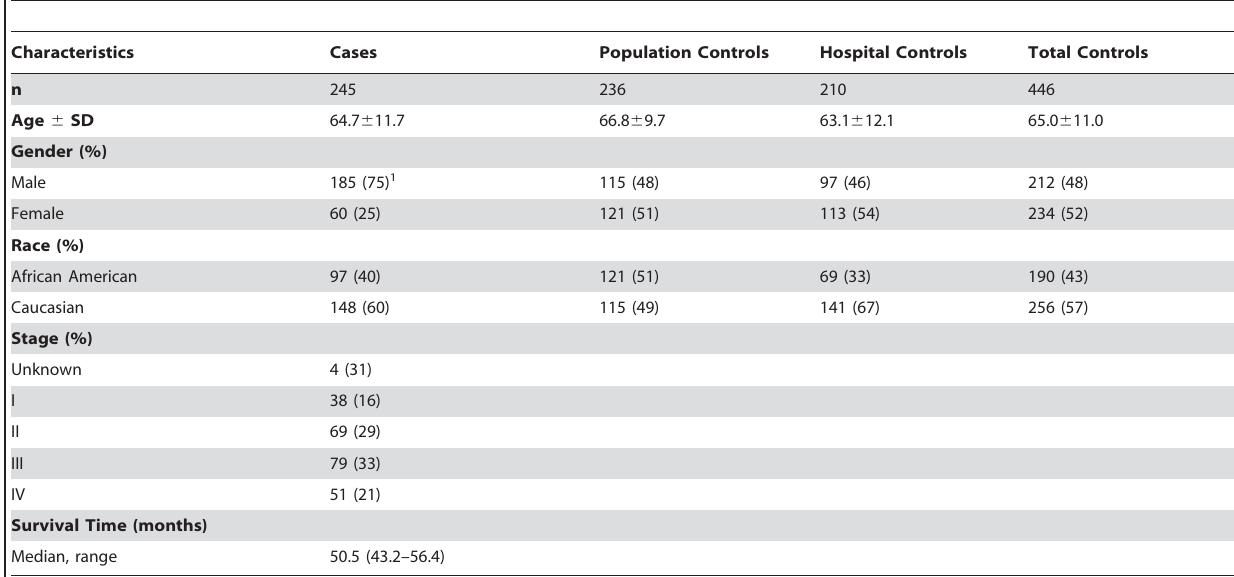
Table 1. Demographic characteristics of the NCI-University of Maryland colorectal cancer case control study